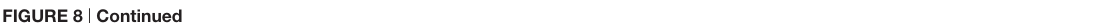
FigUre 8 | continued effect of d -aP5 upon the ca3- and sub-origin epileptiform discharges . (a) An example slice mounted on micro-electrode array. (B) The long-term display of the epileptiform discharges before ( − 2,560 s), during ( − 3,600 s), and after ( − 2,726 s) d -AP5 application, which were recorded by four electrodes (numbers 66, 25, 52, 86) in (a) , corresponding to the epileptiform discharges induced by high-K + artificial cerebrospinal fluid in the DG, CA3, CA1, and subiculum,